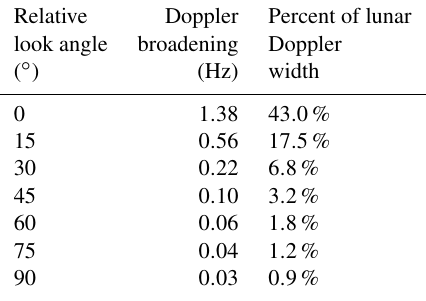
Figure 6. All dates on which the lunar face is more than 30 ◦ over the horizon during 2022, as viewed from the EISCAT 3D Skibotn site. Note that each spike is a lunar month, and every lunar month has several days on which observations are